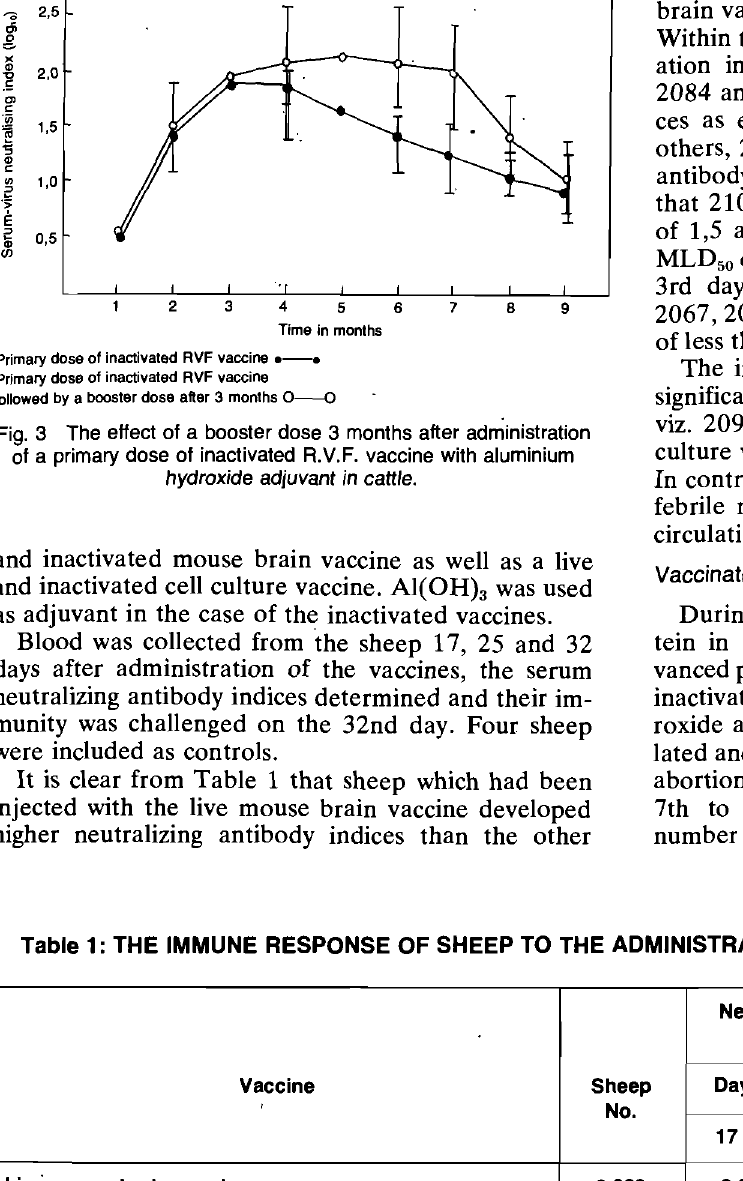
Table 1: THE IMMUNE RESPONSE OF SHEEP TO THE ADMINISTRATION OF 4 EXPERIMENTAL RVF VACCINES